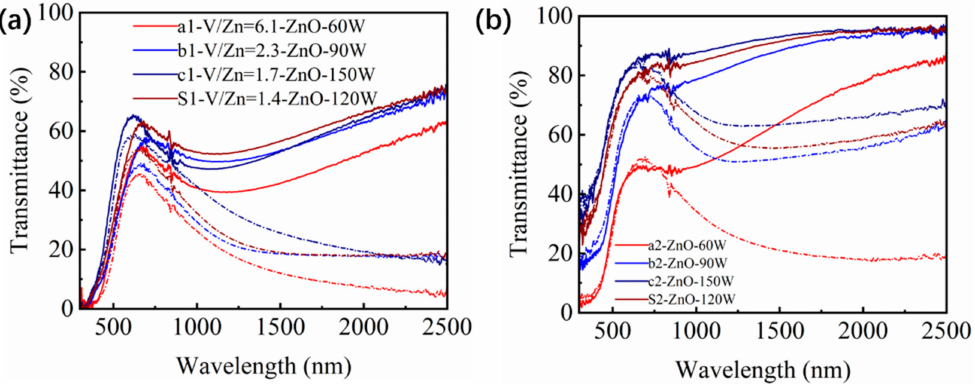
Figure 7. The transmittance of ( a ) Zn 2 V 2 O 7 -VO 2 composite films: a1, b1, c1 and S and ( b ) porous VO 2 films obtained by acid solution treatment of Zn 2 V 2 O 7 -VO 2 composite films: a2, b2, c2 and S2 at 20 (line) and 90 ◦ C short point line, respectively.